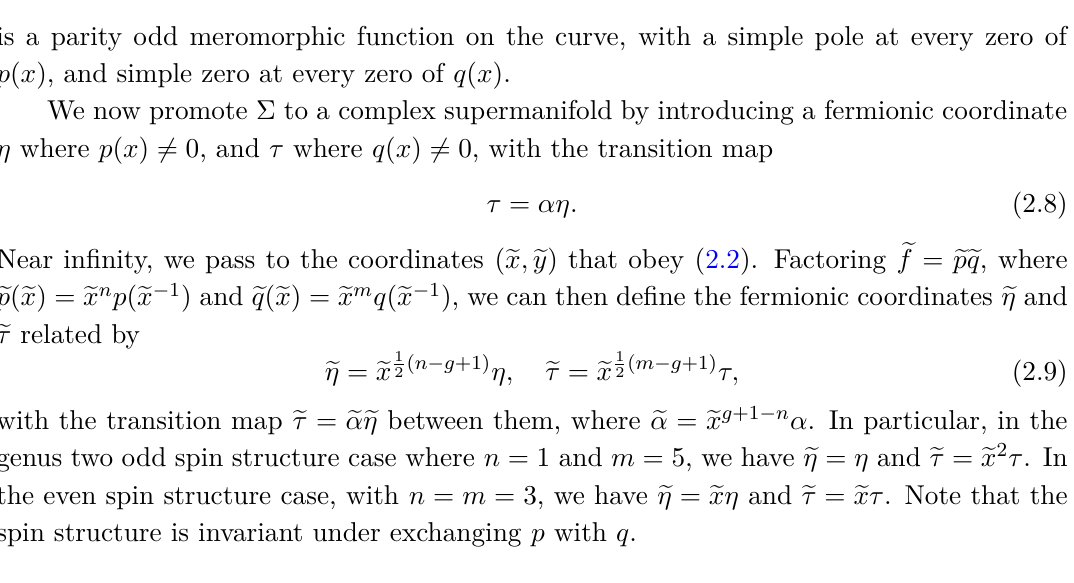
Figure 1 . An illustration of coordinate charts on the super Riemann surface C . The circles represent boundaries of the discs containing the branch points of the underlying hyperelliptic curve, where f ( x ) = 0 . Away from the branch points, the super coordinates are taken to be x together with either η or τ . At the branch points, x degenerates and y is used instead. Near the branch point where q ( x ) = 0 , the disc is parameterized by ( y, η ) whereas τ degenerates. On the other hand, near the branch point where p ( x ) = 0 , the roles of η and τ are